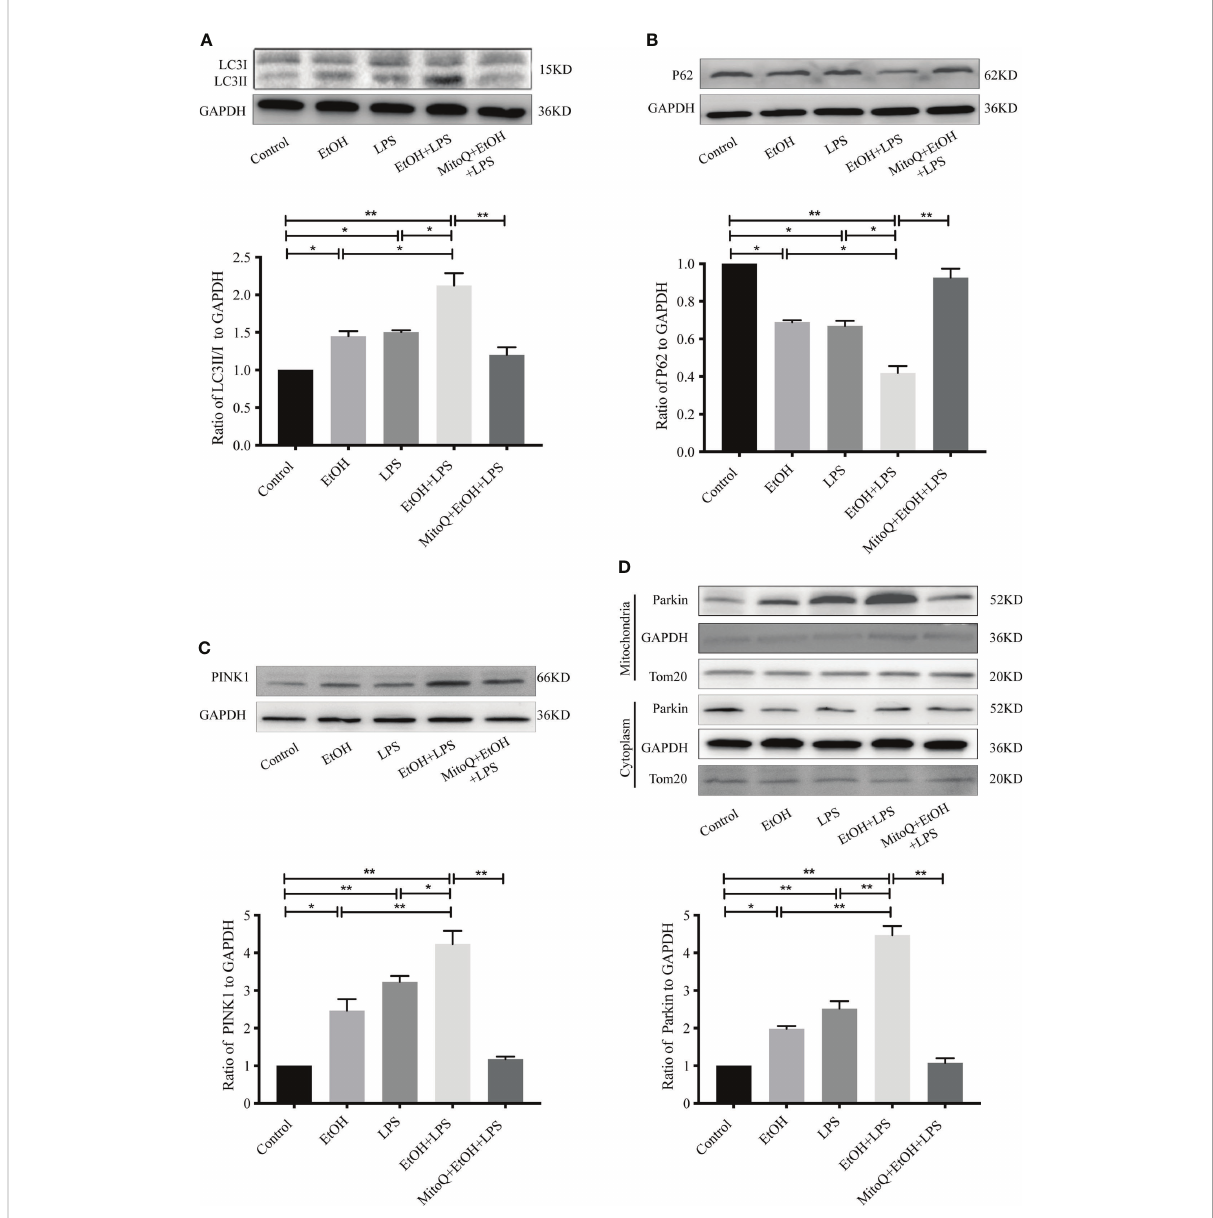
FIGURE 8 MitoQ inhibited ethanol-LPS-induced mitophagy activation in Raw264.7 cells. (A) Expression of LC3 protein was detected by western blotting. (B) Representative western blot images indicated P62 protein expression. (C) Representative western blot images indicated PINK1 protein expression. (D) Expression of Parkin protein in cytoplasm and mitochondria was detected by western blotting. All data were presented as mean ± SEM (n=5 in each group), *P < 0.05, **P <